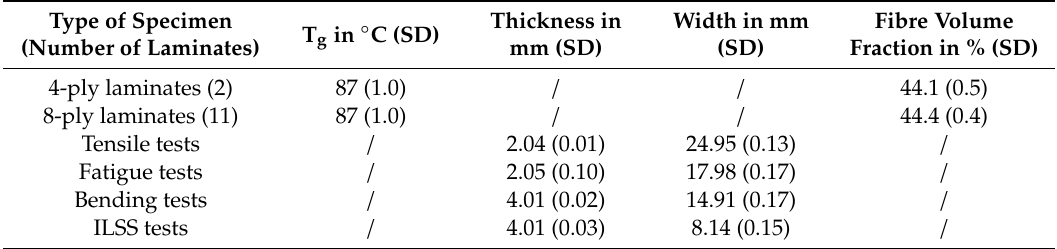
Table 1. Laminate and specimen properties including the standard deviations (SD). In the case of the fatigue samples, the thickness and width are measured at the machined gauge